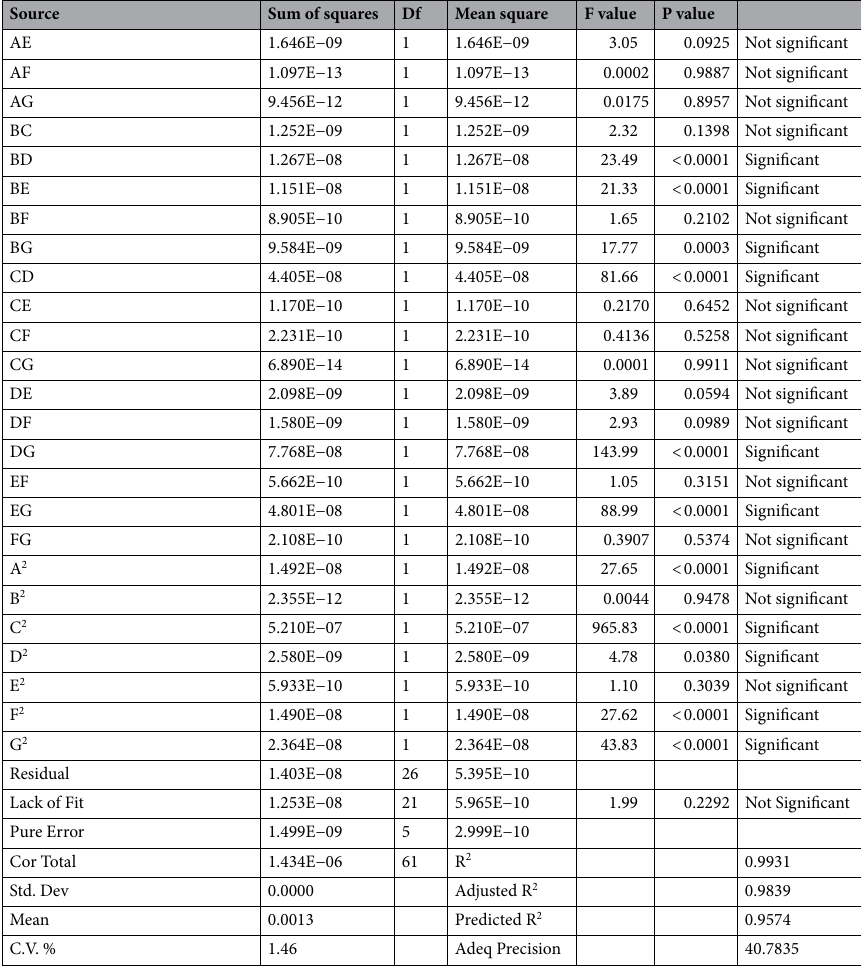
Table 2. Effect of disparate parameters on the PPO and POD activity